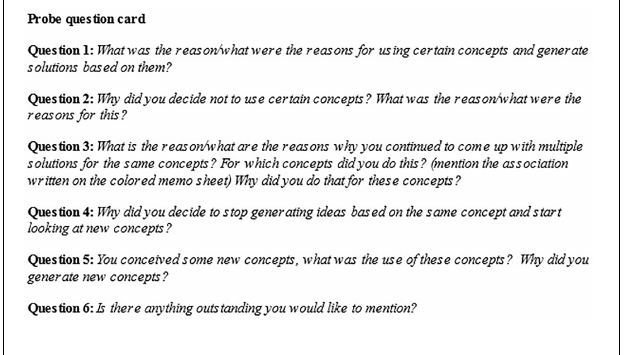
FIGURE 3 | Probe questions used by the researcher to interrogate the reasons for actions taken during the idea generation